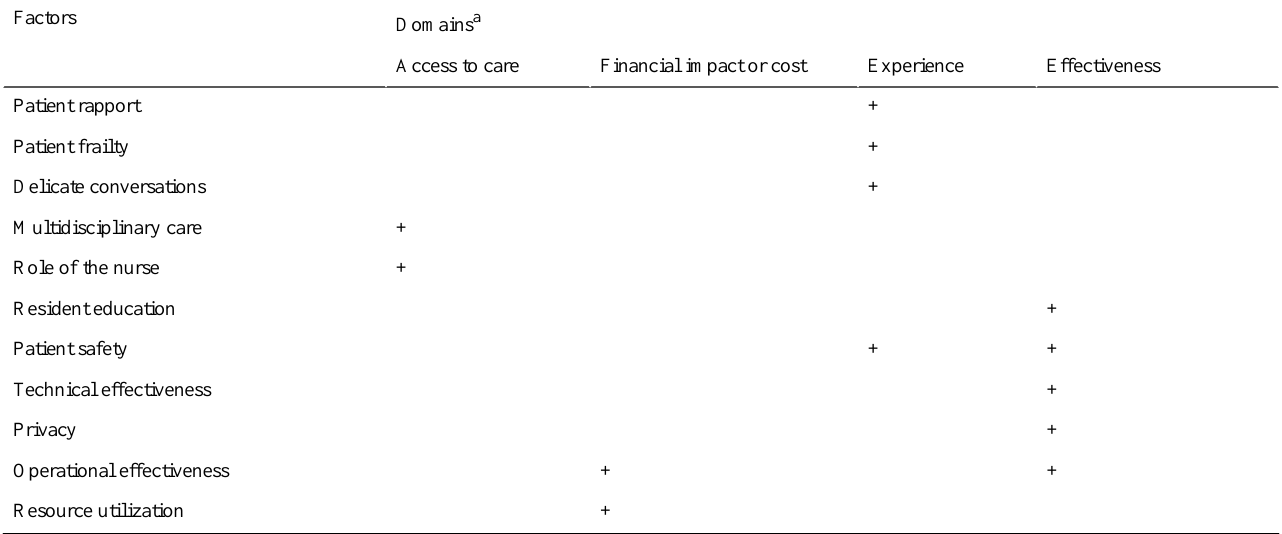
Table 1. National Quality Forum telehealth measurement